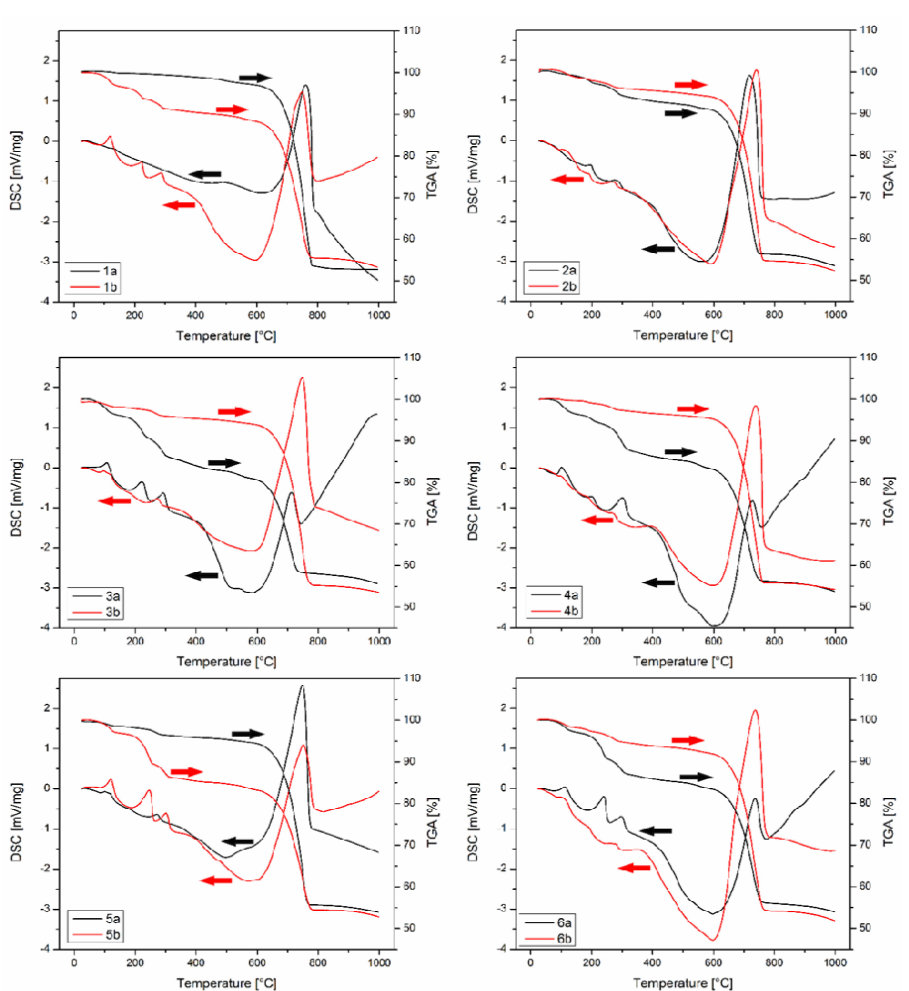
Figure 9. DTA/TGA of CaCO 3 precipitates (a—1st day; b—14th day; 1— S. pasteurii DSM 33; 2— B. muralis ; 3— B. lentus ; 4— B. simplex ; 5— B. firmus ; 6— B. licheniformis ; black arrow—1st day; red arrow—14th